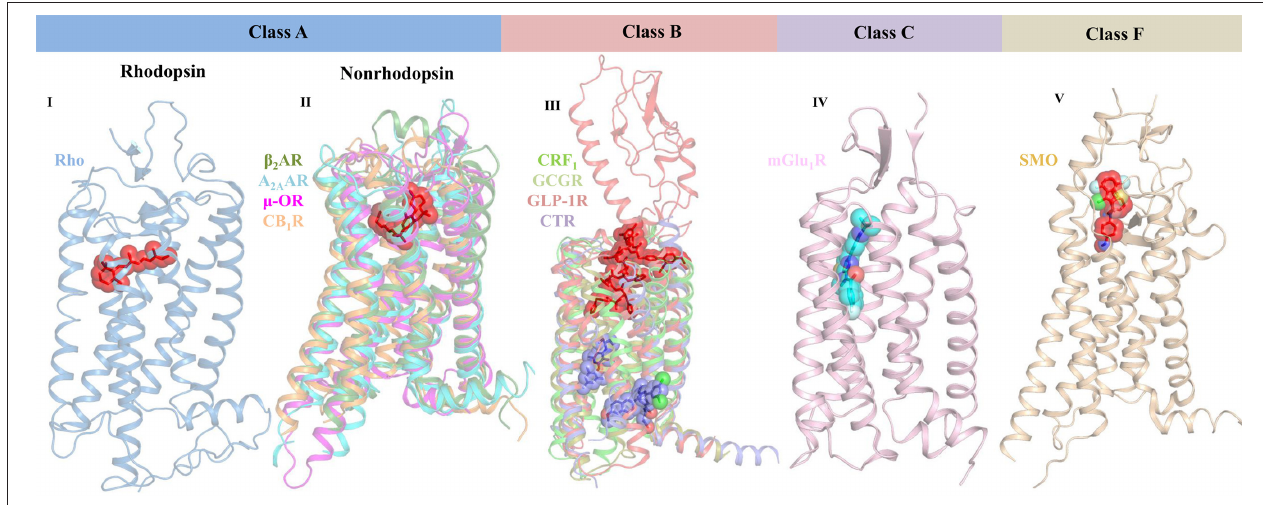
FIGURE 2 | Crystal structures of representative GPCR-ligand complexes from classes A, B, C, and F presenting diverse ligand-binding sites. Class A GPCRs are classified into rhodopsin (bRho, PDB ID: 2HPY) and nonrhodopsin GPCRs. The representative structures of class A nonrhodopsin GPCRs which are further subdivided into aminergic-like ( β 2 AR, PDB ID: 3P0G), nucleotide-like (A 2A AR, PDB ID: 3QAK), peptide-like ( µ -OR, PDB ID: 5C1M), and lipid-like receptors (CB 1 R, PDB ID: 5XRA) along with their bound ligands are shown. Similarly, representative structures for class B (CRF 1 [PDB ID: 4K5Y], GCGR [PDB ID: 5EE7], full-length GLP-1R [PDB ID: 5NX2], and CTR [5UZ7]), class C (mGlu 1 R [PDB ID: 4OR2]), and class F (SMO [PDB ID: 4QIN] bound to negative allosteric modulator) are shown. Receptors are shown in cartoon representation and the ligands are shown as stick models with transparent surfaces. Agonists are represented as red sticks, antagonists are shown as purple sticks, and negative allosteric modulator is shown as blue stick